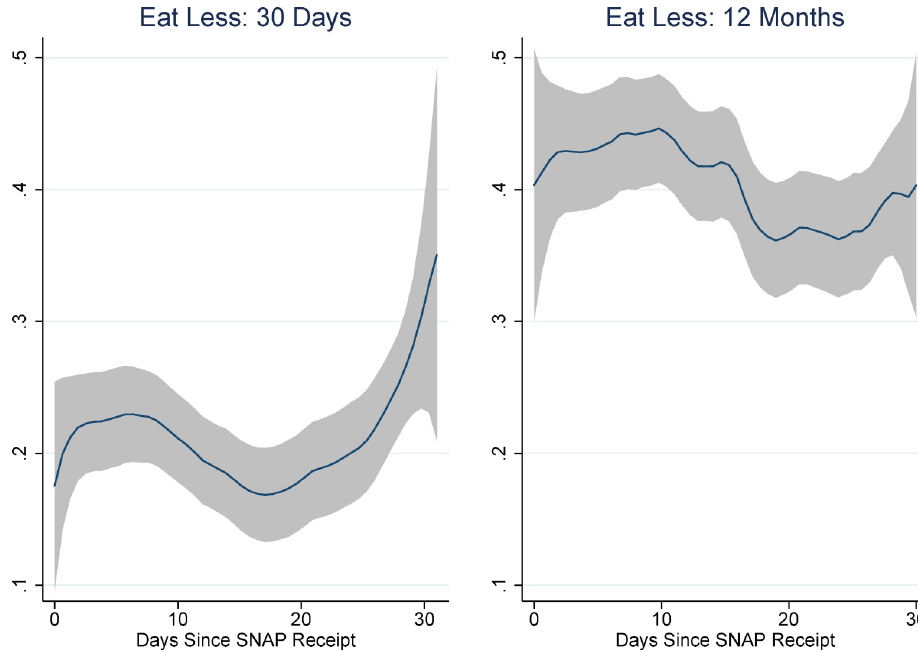
Fig 5. Individual 30-day and household 12-month responses to eat less FSM item and days since SNAP. Source: Authors’ calculations using NHANES data. N = 2,218. Non-parametric regression estimates are weighted.